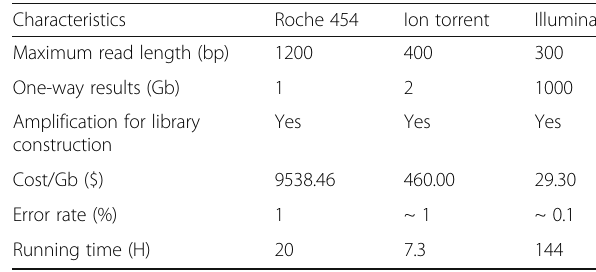
Table 1 Comparison of the characteristics in second-generation